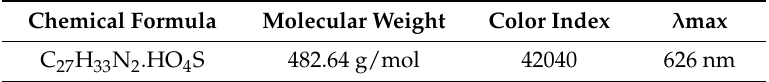
Table 4. Characteristics of brilliant green dye.